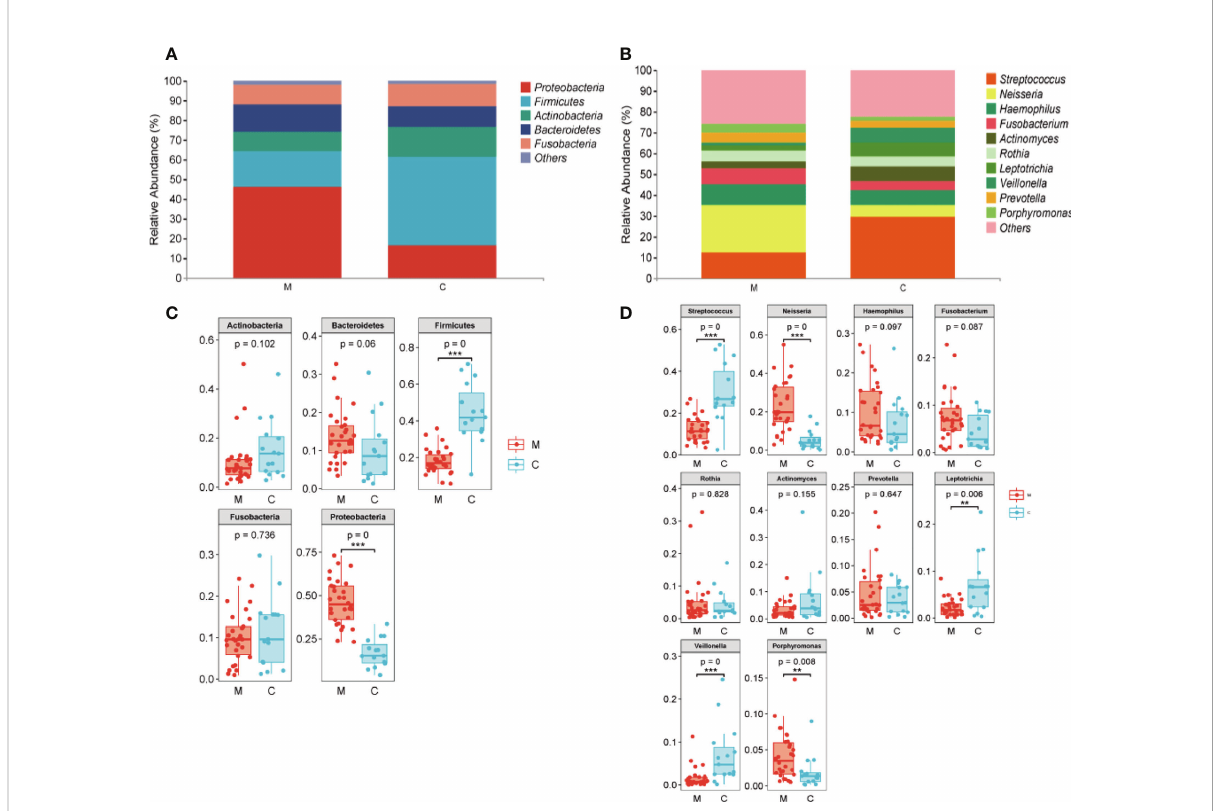
FIGURE 3 Taxa showing differences in relative abundance between the methamphetamine using (M) and control (C) groups. (A) Top fi ve in abundance at the phylum level, (B) Top 10 in abundance at the genus level, (C) Difference test box diagram at the phylum level, (D) Difference test box diagram at the genus level. *p < 0.05, **p < 0.01, ***p <